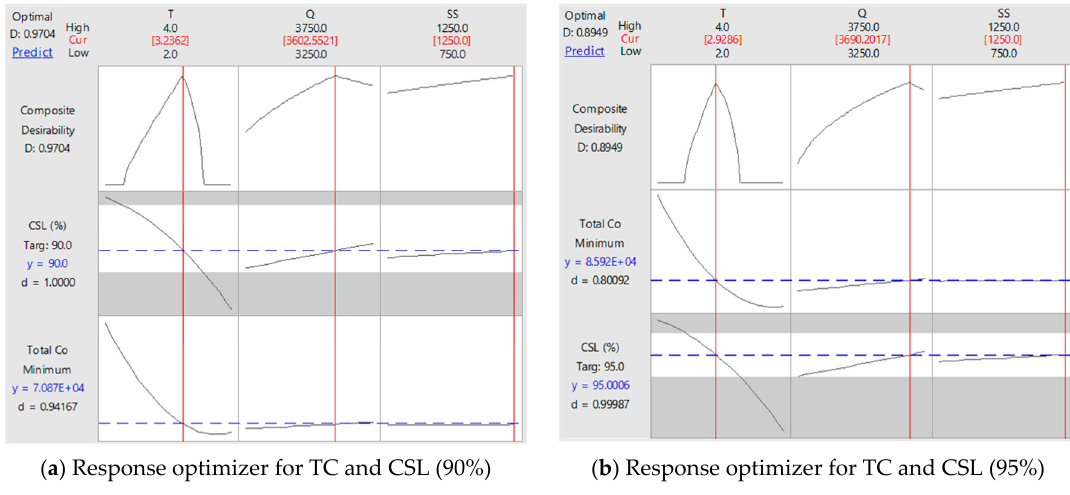
Figure 21. BBD—response optimizer for TC and CSL.